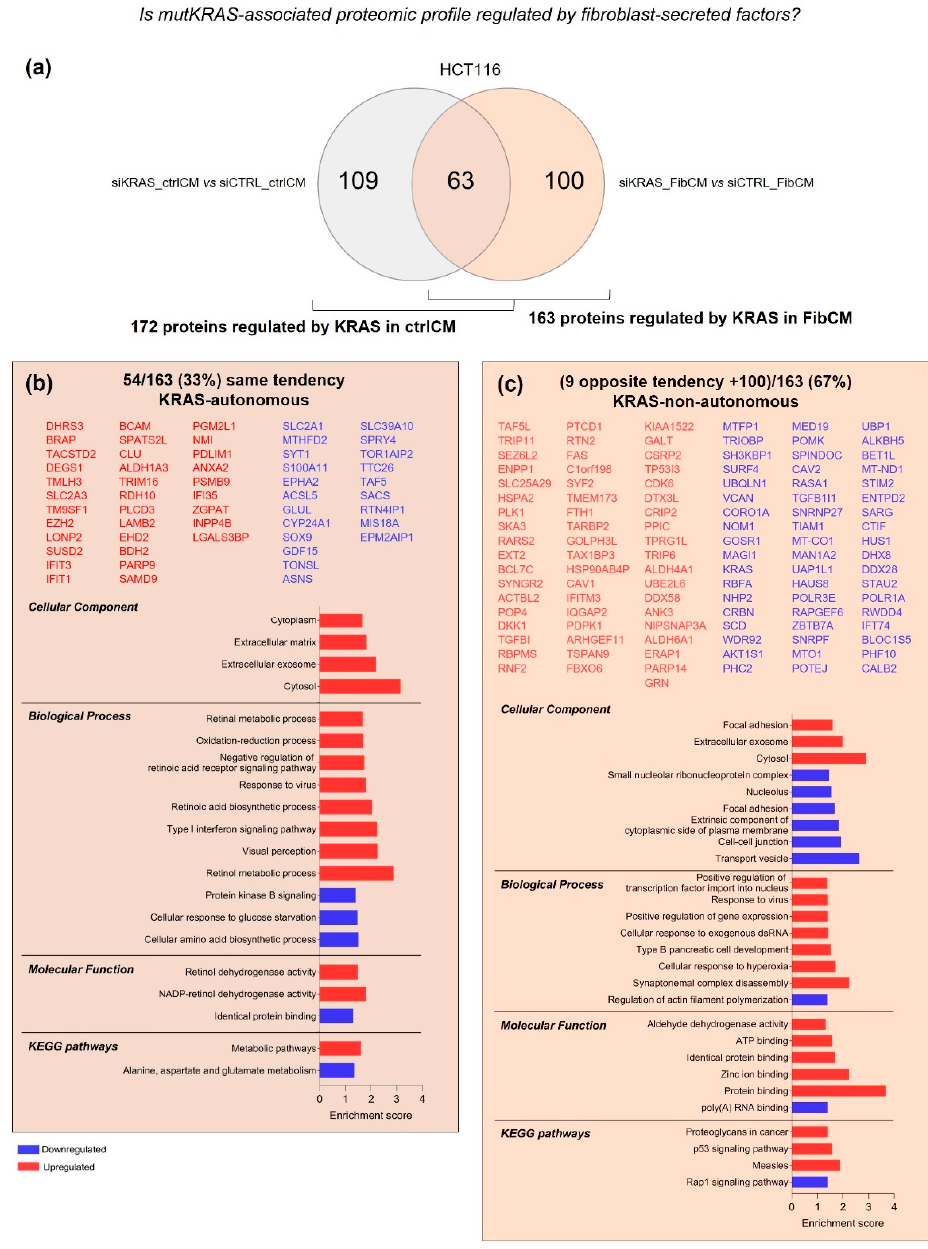
Figure 4. KRAS—autonomously and non-autonomously controlled proteins in HCT116 cells . ( a ) Venn diagram showing the number of exclusive and common proteins identified in the analyzed conditions (siKRAS_ctrlCM vs. siCTRL_ctrlCM and siKRAS_FibCM vs. siCTRL_FibCM). ( b , c ) GO and KEGG pathways analysis of shared proteins following the same expression tendency (KRAS-autonomous) ( b ), and shared proteins with opposite expression tendencies together with exclusive proteins from siKRAS_FibCM vs. siCTRL_FibCM comparison (KRAS-non-autonomous) ( c ). Protein lists are organized according to the abundance ratio. The enrichment score was calculated by—log p